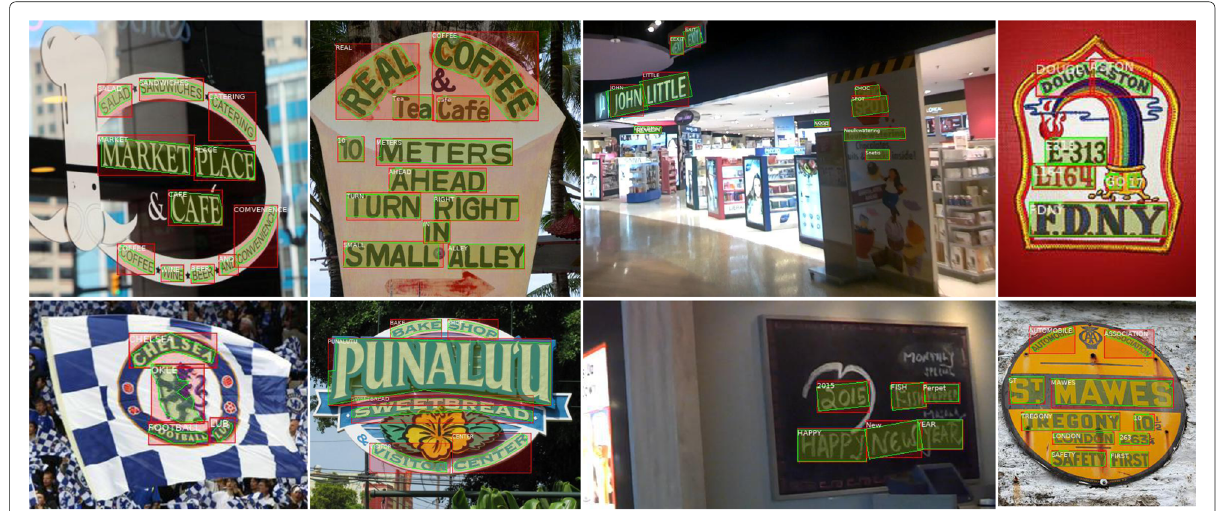
Fig. 6 Examples of text spotting results of our text spotting model on the three